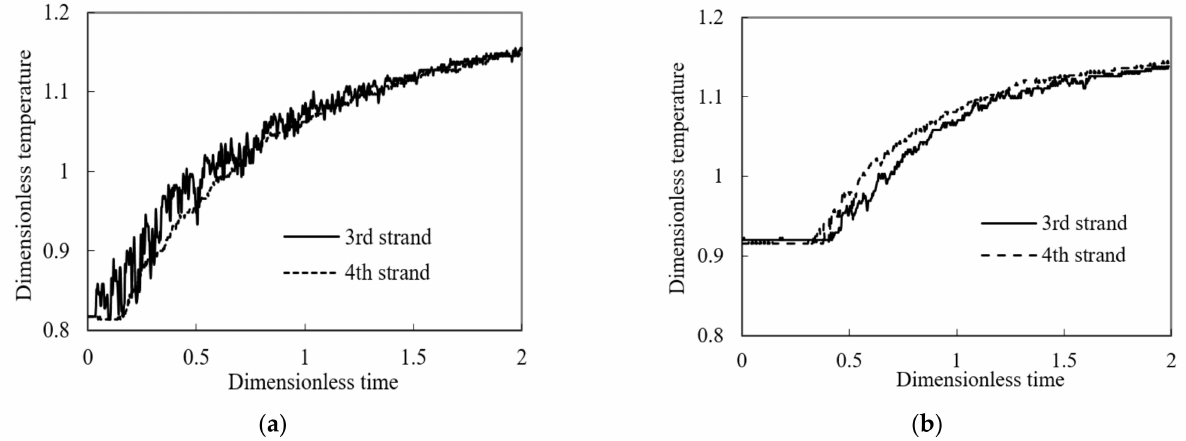
Figure 6. The temperature curve measured in the non-isothermal model experiment. ( a ) Without FCDs; ( b ) with optimized FCDs.